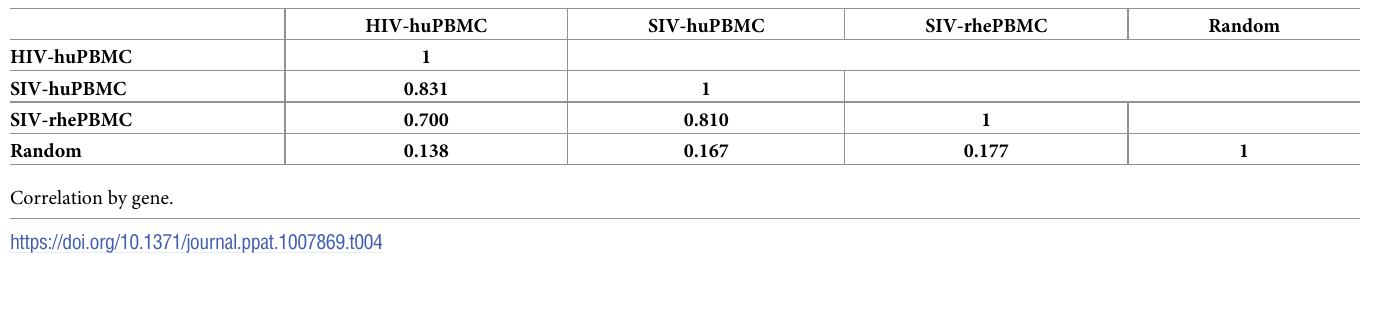
Table 4. Correlation of the distribution of HIV and SIV integration sites (by